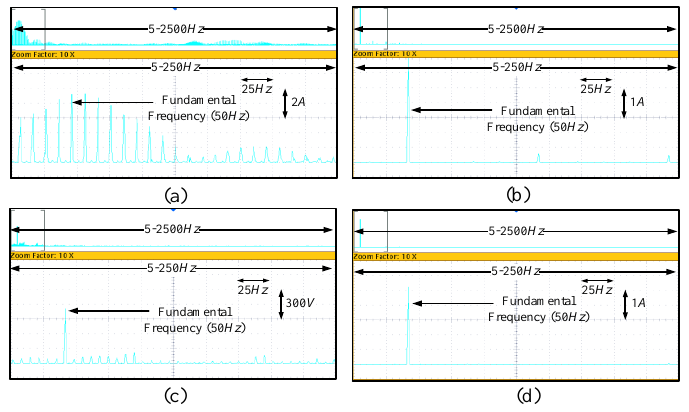
Figure 20. Fast Fourier transform (FFT) Analysis around fundamental frequency ( a ) input current on